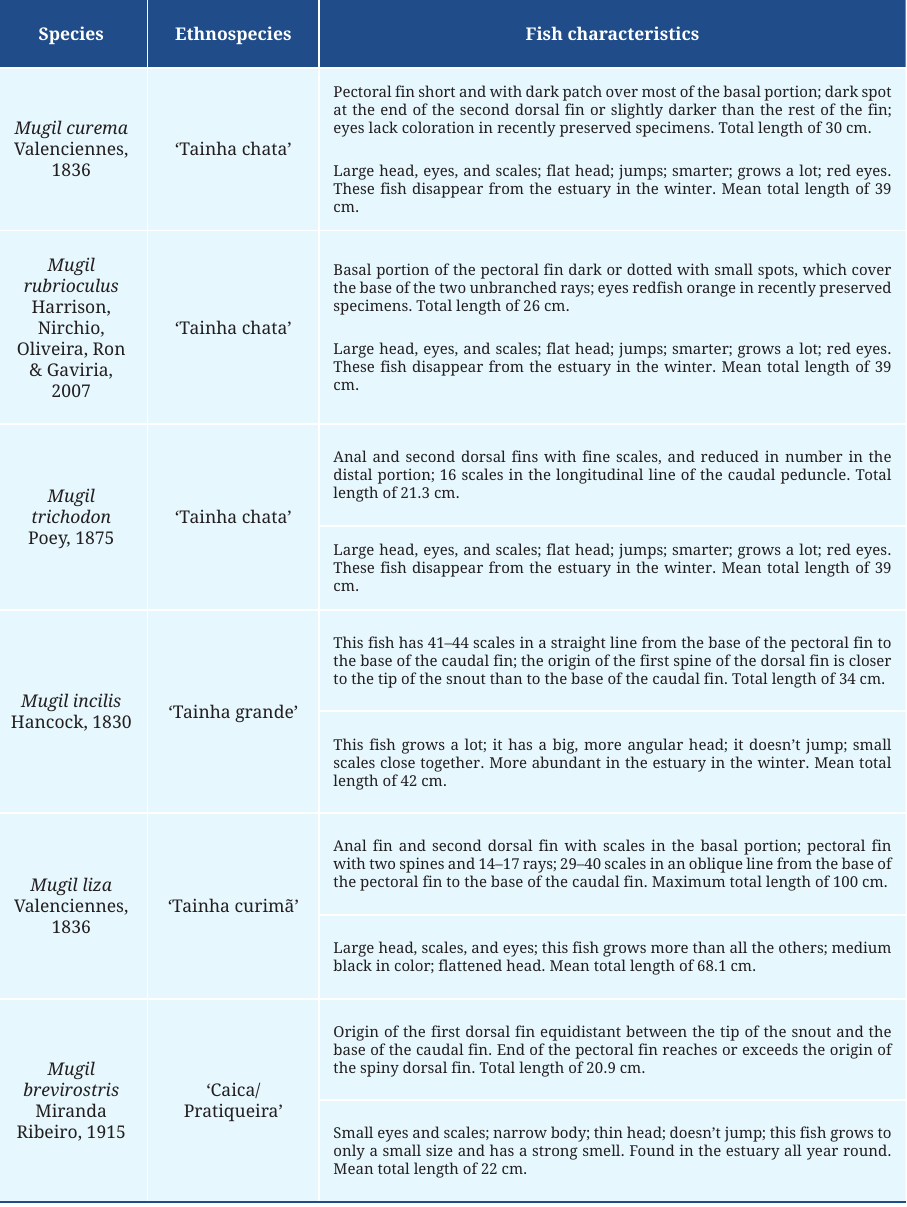
TABLE 3 | Comparison of the folk and scientific taxonomies of the species of the genus Mugil (Menezes et al ., 2015) identified by the artisanal fishers of the Caeté-Taperaçu Marine Extractive Reserve in Bragança, northern